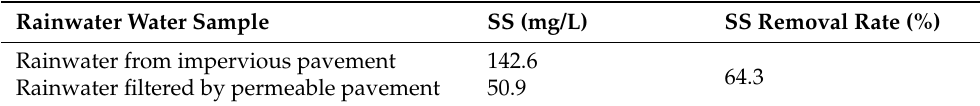
Table 5. Suspended solid (SS) content of experimental rainwater